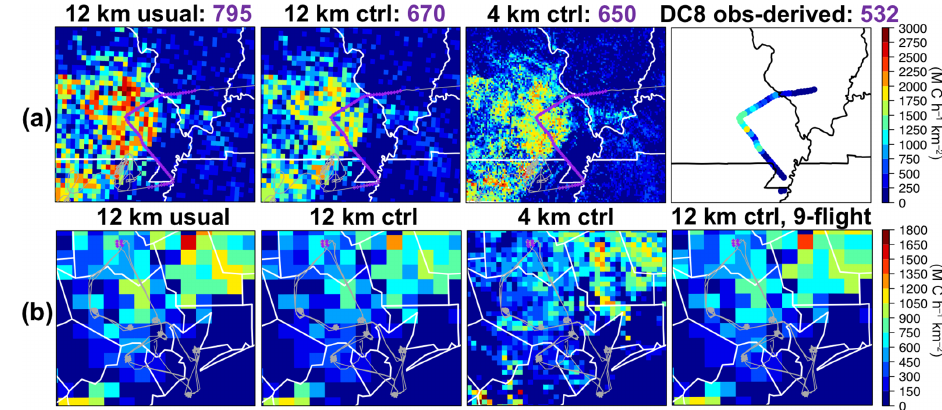
Figure 6. (a) Isoprene emissions around the isoprene volcano areas in Missouri based on NUWRF–MEGAN and aircraft observations at ∼ 13:00 local standard time on 11 September 2013. The mean values along the DC-8 flight path during 12:30–13:30 local standard time (in purple) are indicated in the figure captions. Open purple dots along the flight path refer to where isoprene data are missing or above the PBL. (b) Isoprene emissions in Houston, TX, from NUWRF–MEGAN on 11 September 2013 and on 9 DISCOVER-AQ flight days in September 2013, at noon local time. The DISCOVER-AQ P-3B flight path on 11 September 2013 is overlaid in grey and the Conroe samples at around noontime are highlighted in purple. Note that the flight paths for all other flight days are similar to but not exactly the same as that of 11 September. Control is denoted by